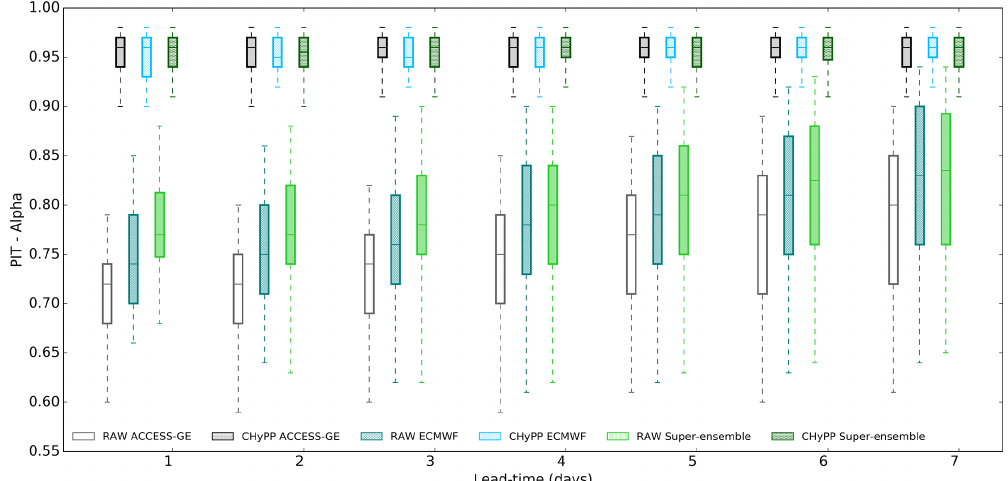
Figure 5. Reliability (PIT-alpha) of different rainfall products (raw and calibrated using CHyPP), ACCESS–GE2, ECMWF, and the super- ensemble for the 100 catchments.